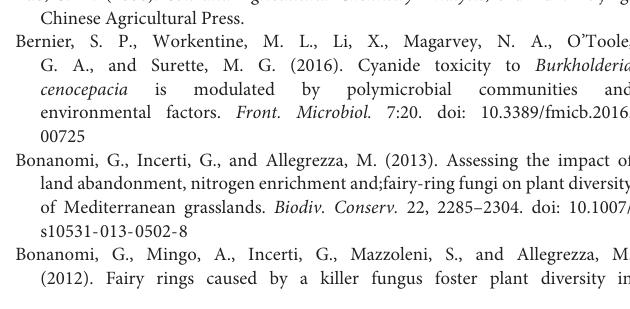
Supplementary Figure 1 | Rarefaction curves based on the sequences of the V3-V4 region of the 16S rRNA gene and ITS region amplified of the fungi eukaryotic ribosomal RNA gene from fairy rings samples. The abscissa indicates the number of extracted tags; the ordinate indicates the expected number of OTUs that can be obtained when a certain number of tags were extracted. (A) bacteria; (B) fungi. Supplementary Figure 2 | Venn diagram showing the common and unique bacterial and fungal OTUs among different samples associated with OUT and ON zone from fairy rings. (A) bacteria; (B) fungi. Supplementary Figure 3 | Principal component analysis (PCA) was used to compared of microbial community structure between different samples of fairy rings in OTUs level (at 97% similarity). (A) bacteria; (B) fungi. Supplementary Figure 4 | Phylogenetic analysis of the 16s rRNA gene sequence of BG-5. The phylogenetic tree was constructed using the neighbor-joining method. Bootstrap analysis with 1000 replications was performed to assess the topology of the phylogenetic trees. The evolutionary distances were calculated using Kimura’s two-parameter model. Supplementary Table 1 | Qualitative testing of plant growth promoting function of isolated strains from fairy ring soil. Positive result of plant-growth-promoting activity are indicated by “ + ”, negative result of plant-growth-promoting activity are indicated by “ −